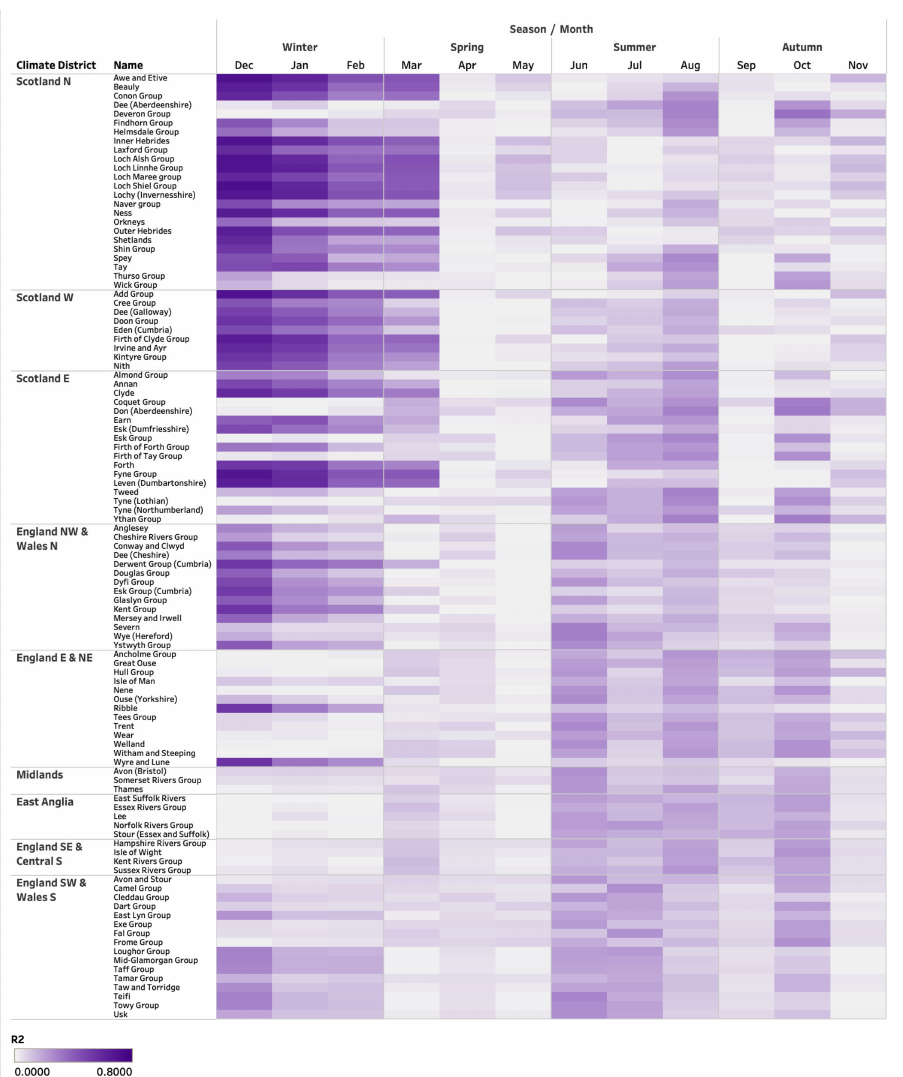
Figure 2. R 2 values of the univariate regression model exploring the relationship between the NAO index and SPI-1 values across the IHU Groups. Climate Districts relate to the nine Met Office Climate Distracts of Great Britain–a spatial unit used in previous research